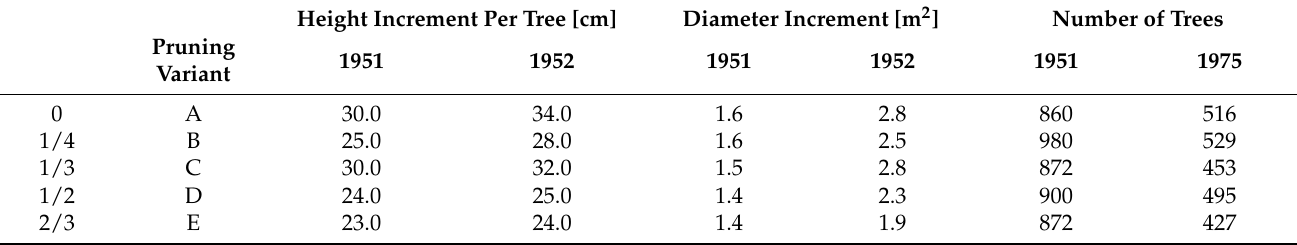
Table A2. Height and diameter increment.